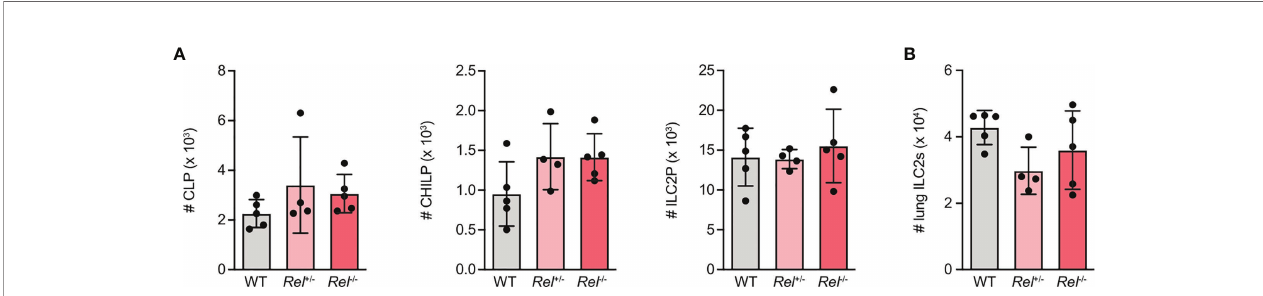
FIGURE 2 | c-Rel-de fi cient group 2 innate lymphoid cells (ILC2s) exhibit no intrinsic defects in their developmental capacity. Flow cytometric analysis of total numbers of (A) ILC2 precursor populations CLP (left), CHILP, (middle) and ILC2 progenitor (ILC2P) (right) as well as (B) pulmonary ILC2s in wild-type (WT), heterozygous Rel +/ − , and homozygous Rel − / − littermate control mice. Data points are representative of two independent experiments with n = 4 – 5 mice per treatment group (A, B) . Data are shown as mean ± SD as determined by one-way ANOVA followed by Tukey ’ s multiple comparisons test. CLP, common lymphoid progenitor; CHILP, common helper ILC2 progenitor; ILC2P, ILC2